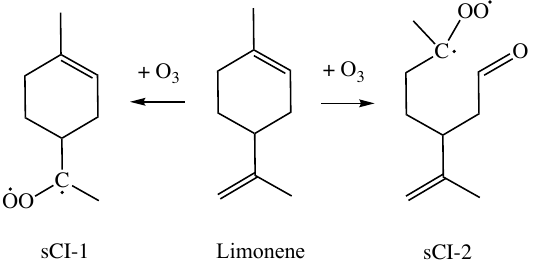
Scheme 1. Formation of disubstituted sCIs from limonene ozonol-